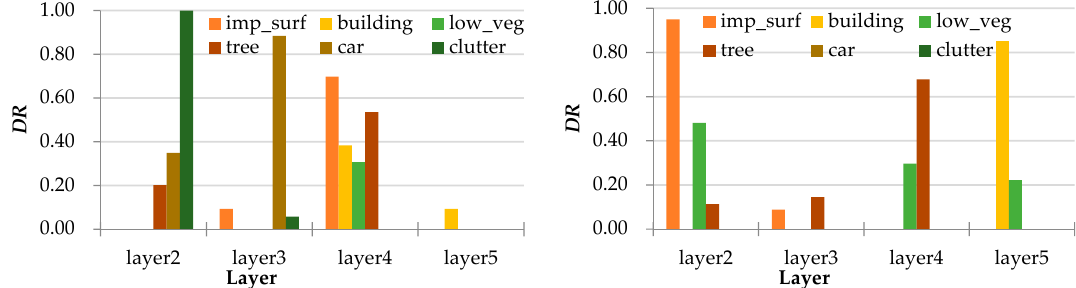
Figure 3. The DR (descent rate of recall) of different layers. The left graph is for imagery, the right for elevation data.